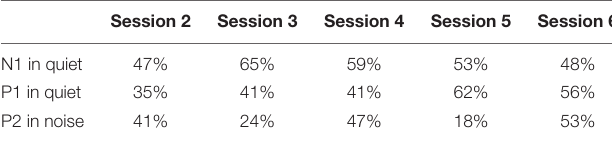
TABLE 4 | Percentage of the individuals that met the clinical criteria of